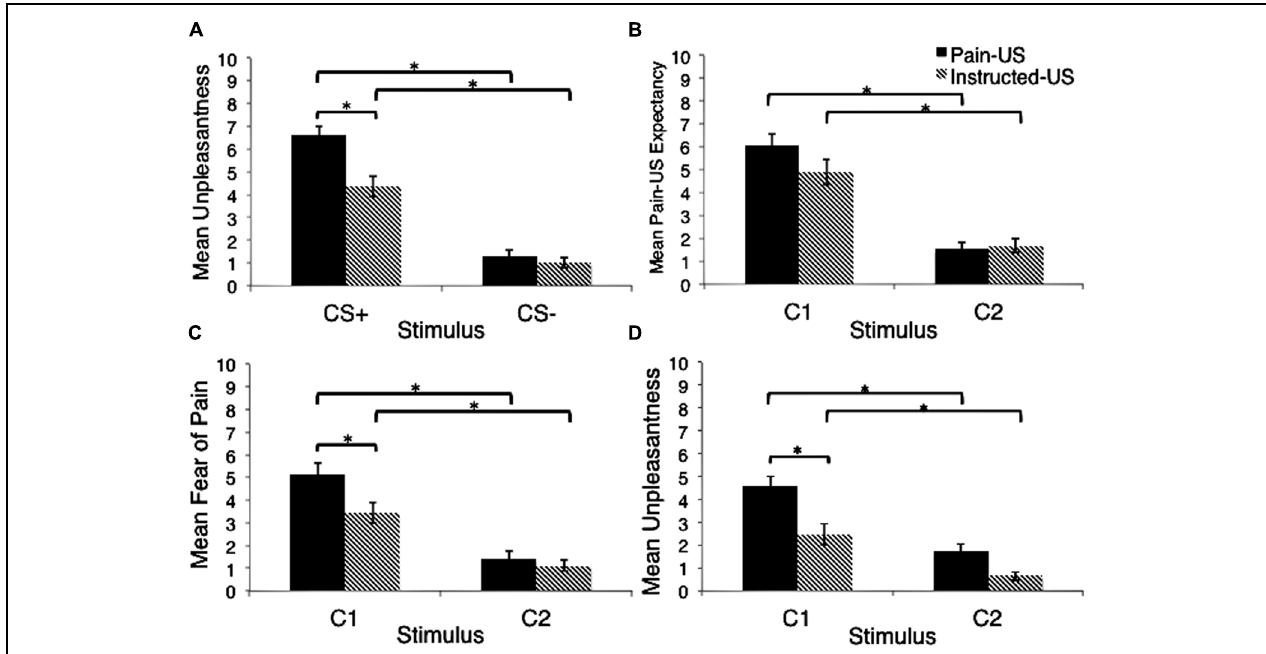
FIGURE 3 | (A) Mean unpleasantness ratings for the original CSs. This was a manipulation check to ensure complete conditioning. (B) Mean pain-US expectancy ratings for movements equivalent to the original CSs. (C) Mean fear